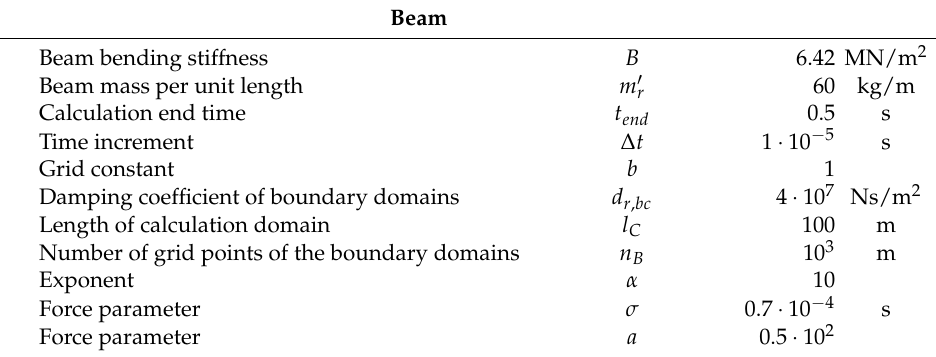
Figure A2. Error Err s of the simulation depending on d r , bc for varying m (cid:48) r / ∆ t . (The unspecified parameters are presented in Table A1.) Table A1. Parameters of the infinite unsupported